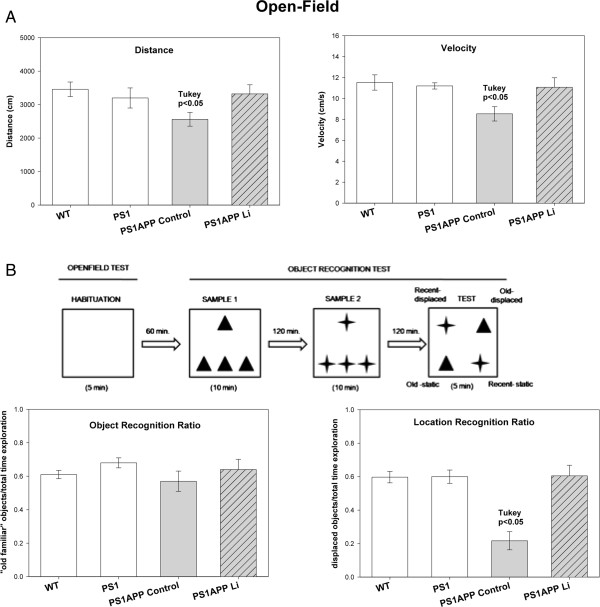
Lithium treatment improved the behavioral/memory deficiencies of PS1xAPP mice. (A) Open-field test. One-way ANOVA revealed significant differences between groups in both distance (F(3,24) = 6.33; p = 0.006) and velocity F(3,24) = 8.02, p = 0.002). Post-hoc analysis showed significant differences in PS1xAPP control compared with WT/PS1 and PS1xAPP lithium (p < 0.05). (B) Behavioral protocol and memory measures. Sixty min after habituation to the open-field, animals received three samples trials with 120 min inter-trial as depicted. Each symbol (triangle and star) represents one type of object. One-way ANOVA F(3,24) = 21.15 p = 0.0001) revealed significant differences between groups in place memory index. Post-hoc analysis showed significant difference in PS1xAPP control compared with WT/PS1 controls and PS1xAPP lithium.